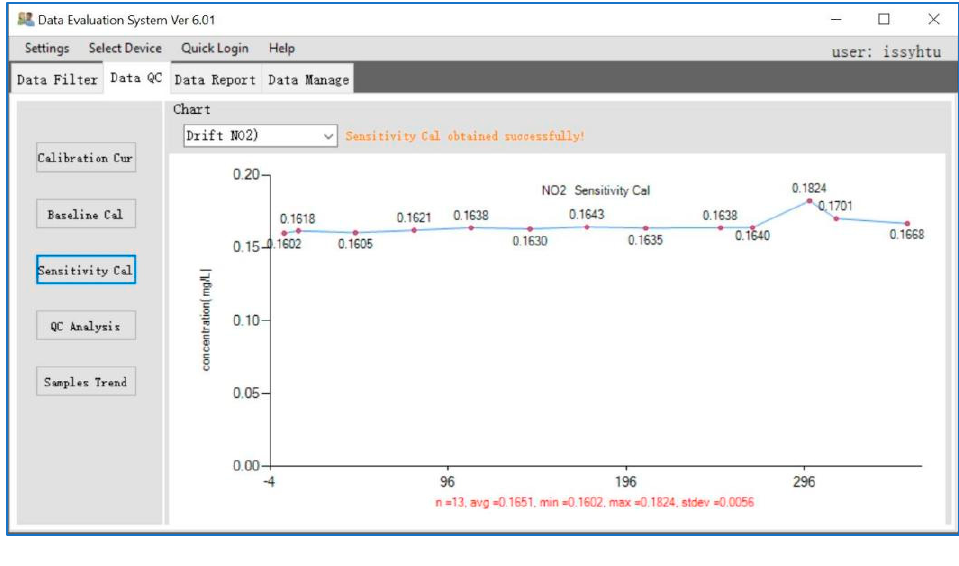
13 of 18 Figure 11. Detection calibration curve.